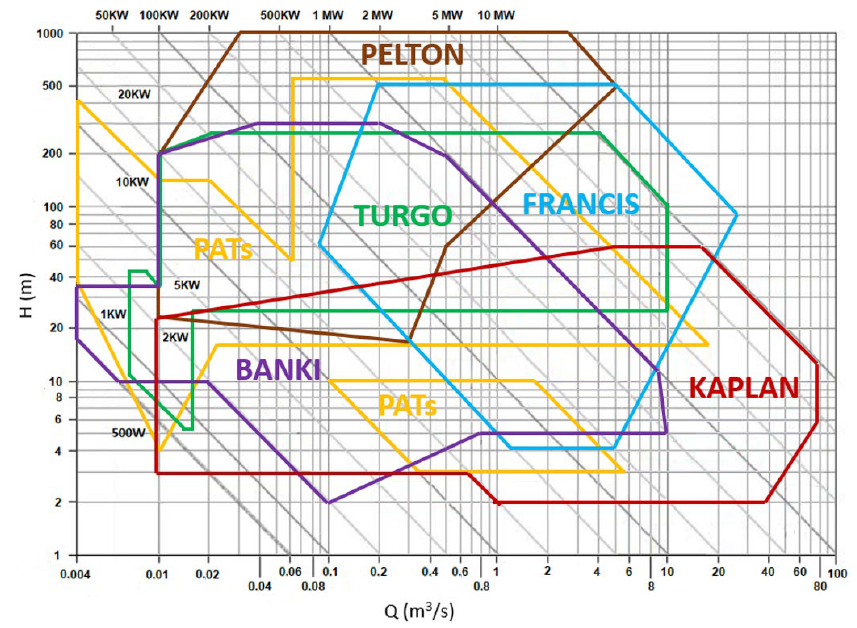
Figure 1. Diagram net head (H)-flow rate (Q) for the selection of turbines and PATs (Pumps as Turbines) according to operation requirements.